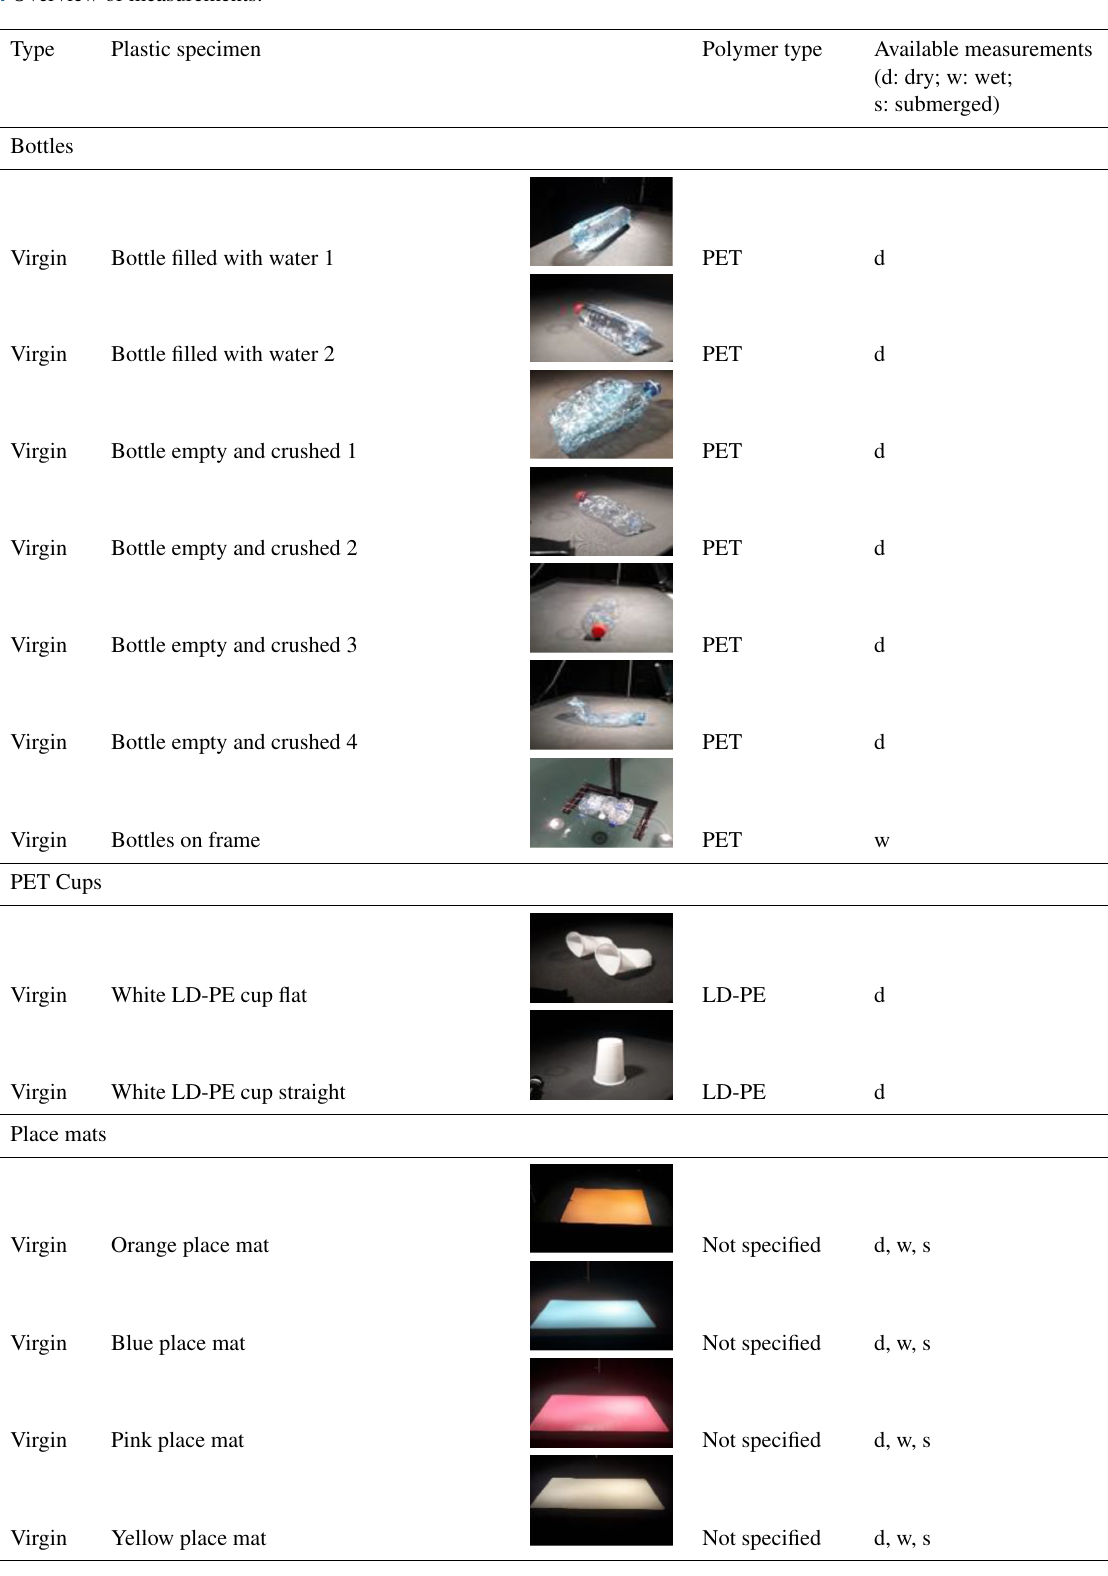
Table 2. Overview of